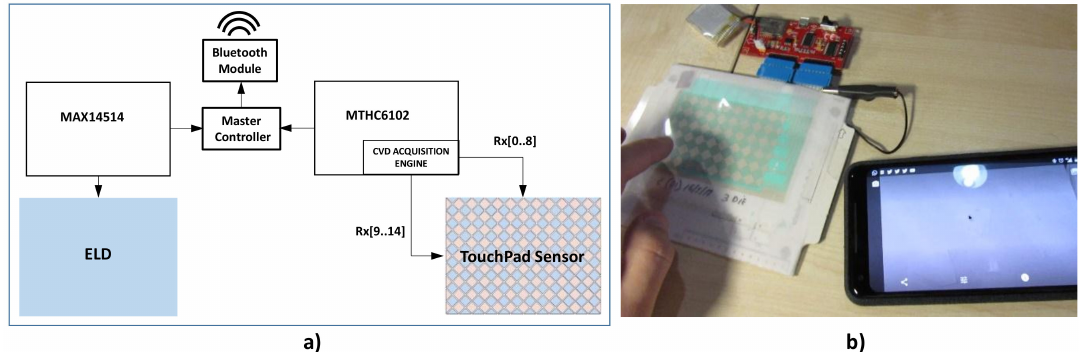
Figure 3. Electronic System Block Diagram ( a ); real electronic system applied to a mouse control in a mobile phone ( b